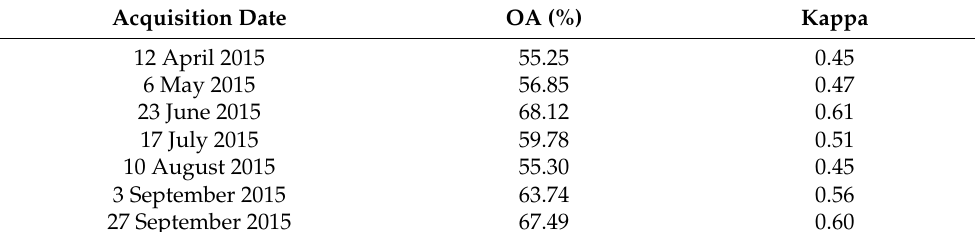
Table 8. Accuracy assessment of RF classifications with all polarimetric observables using single SAR image on each date after exchanging the training and testing samples in previous tests.